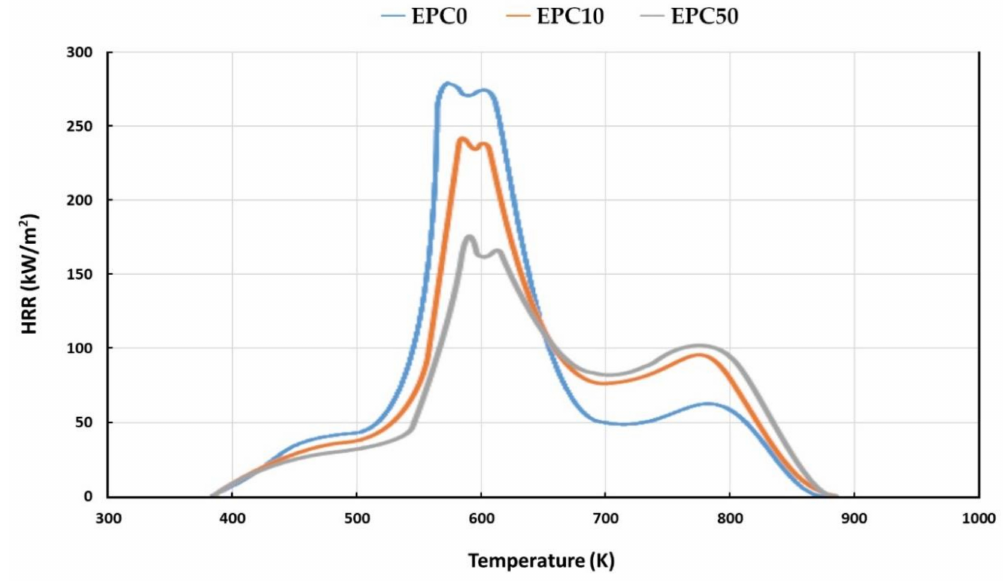
Figure 4. Dependence of the heat release rate (HRR) of selected RPU/PIR foams on temperature. The HRR curves of the selected RPU/PIR foams showed two decomposition